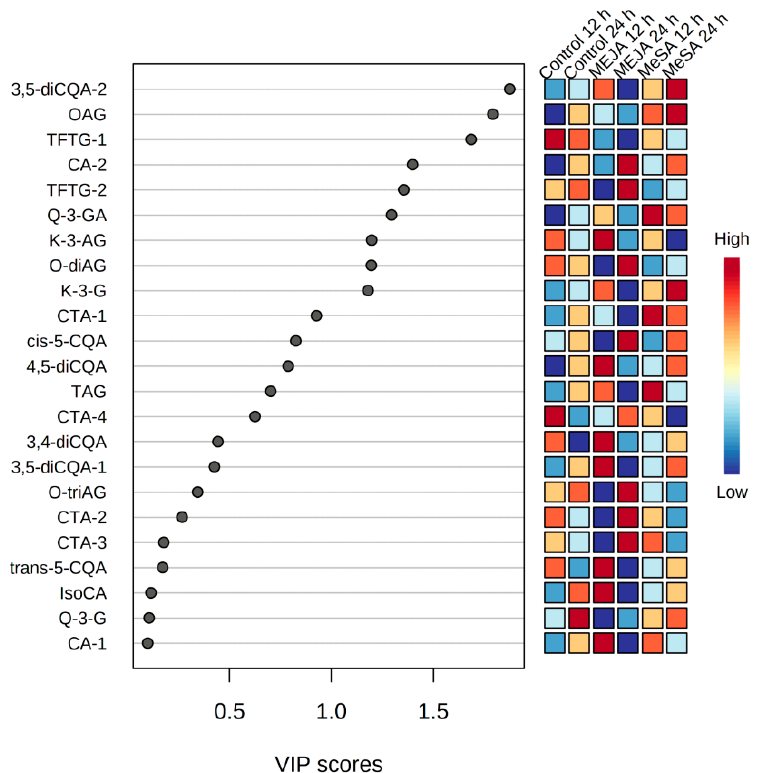
Figure 4. Variable importance in projection (VIP) scores generated from partial least squares discriminant analysis (PLS-DA). Indicated are discriminating ions leaves of Bidens pilosa treated with 0.5 mM MeSA and MeJA and harvested at 12 h and 24 h time intervals in comparison to the corresponding control samples. Metabolites with a VIP score ≥ 0.5 were considered to be affected by exogenous treatments with MeJA and MeSA. Abbreviations are as listed in Table 1.